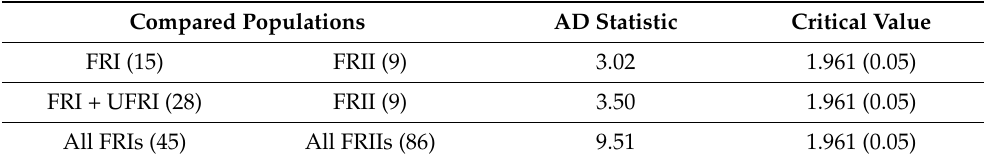
Table 3. Results of the Anderson-Darling test that has been used to assess the low-frequency radio luminosity (as an indicator for AGN jet power) of FRI and FRII quasars.